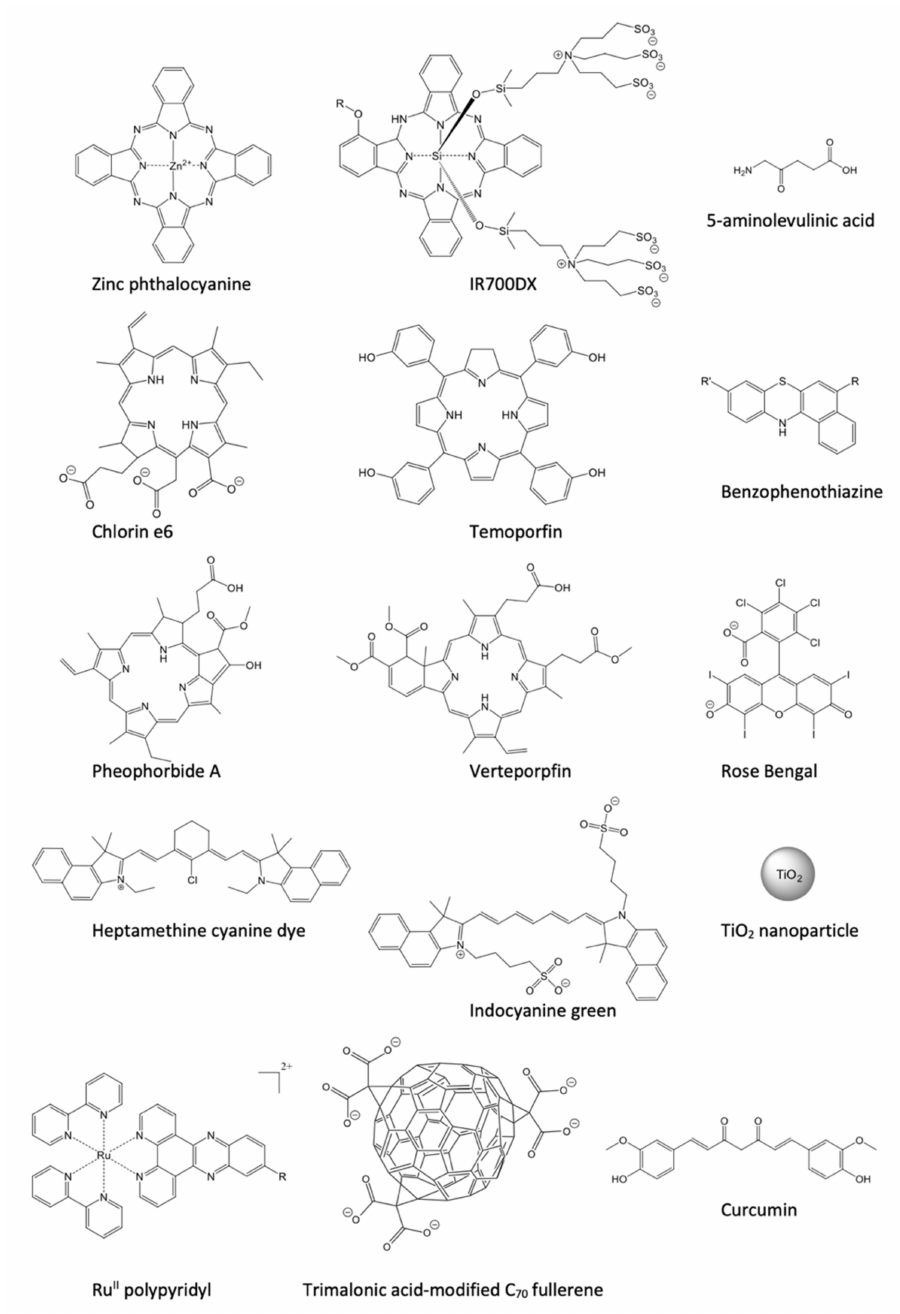
Figure 2. Representative photosensitizers (PS) used in EGFR-targeted